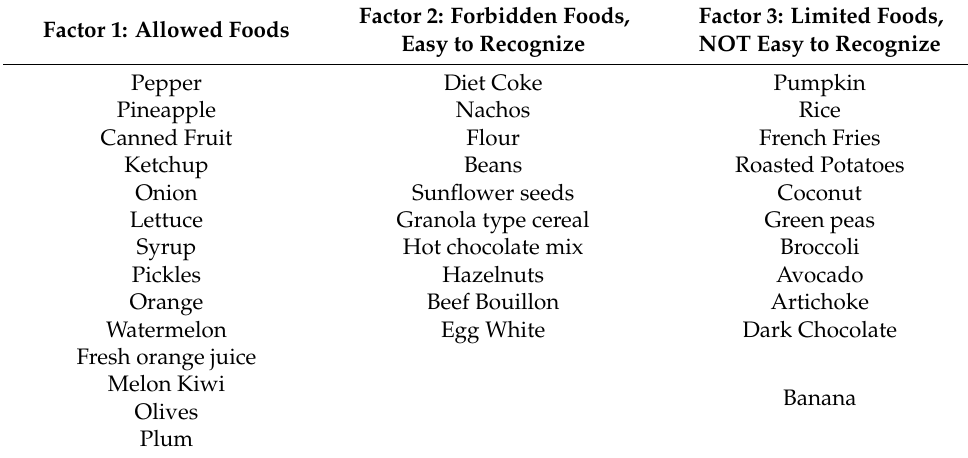
Table 2. Factorial structure of